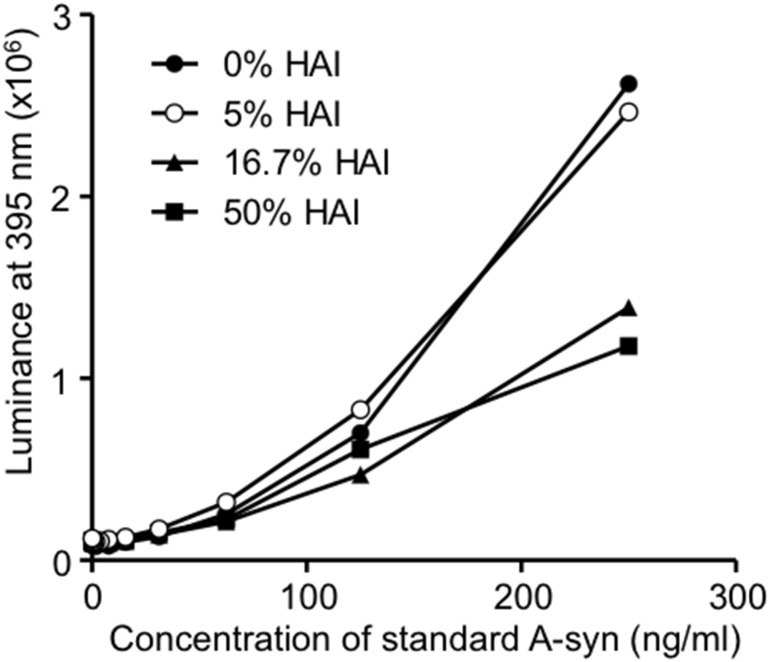
Determination of the optimal HAI concentration for the A-syn 211-FL140 ELISA.Chemiluminescence signals obtained from serially diluted recombinant A-syn in the presence of various HAI concentrations (0, 5, 16.7 and 50%) with the 211-FL140 ELISA. ELISA performance was not affected by 5% HAI, and was reduced in the presence of 16.7% and 50% HAI.